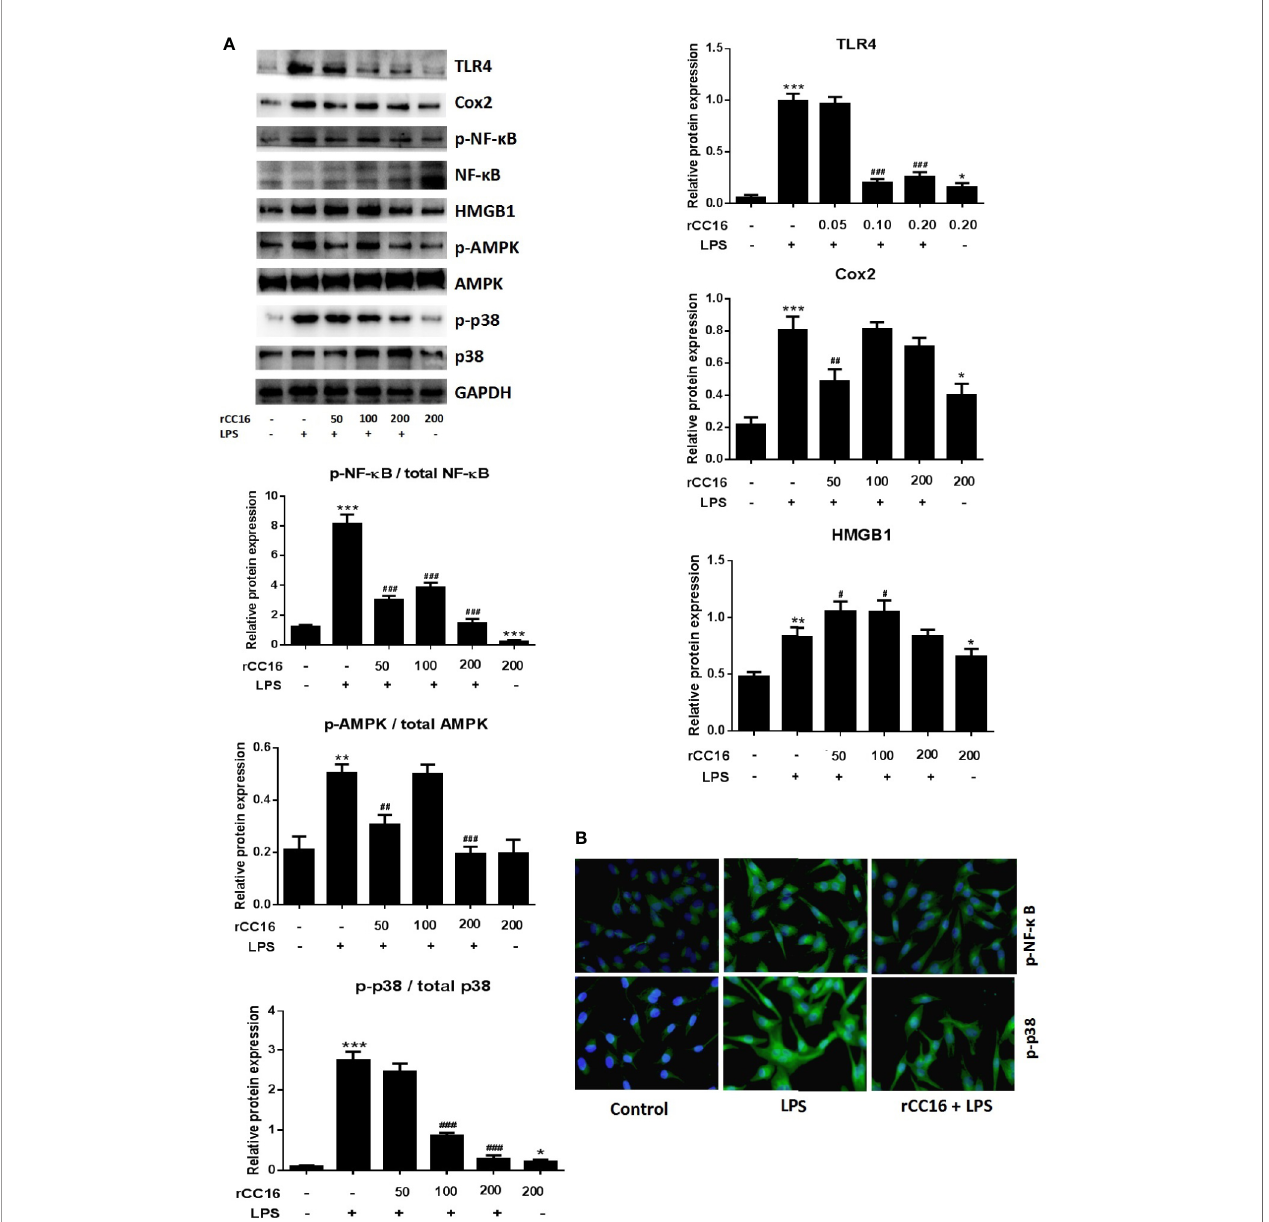
FIGURE 8 | rCC16 suppressed the LPS-induced activation of the TLR4/NF- k B/MAPK pathway. (A) Western blot analysis and quanti fi cation of apoptosis-related proteins and TLR4/NF- k B/MAPK signaling-related proteins in A549 cells after pretreatment with 0-200 m g/ml rCC16 for 12 h and treatment with or 200 m g/ml LPS for an additional 24 h. (B) Immuno fl uorescence detection of p-NF- k B and p-p38 after pretreatment with or without 0.2 m g/ml rCC16 for 12 h and treatment with 200 m g/ml LPS for an additional 24 h. # p < 0.1, # p < 0.01, ### p < 0.001 compared with the untreated group; *p < 0.05, **p < 0.01, and ***p < 0.001 compared with the LPS group. Graphs show the mean ± SD of triplicate wells and represent three independent